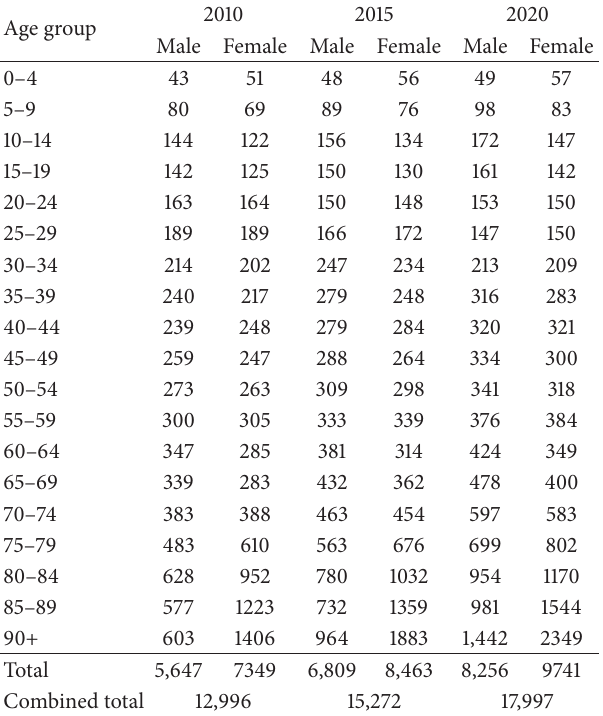
Table 3: The estimated prevalence of blindness in the Republic of Ireland